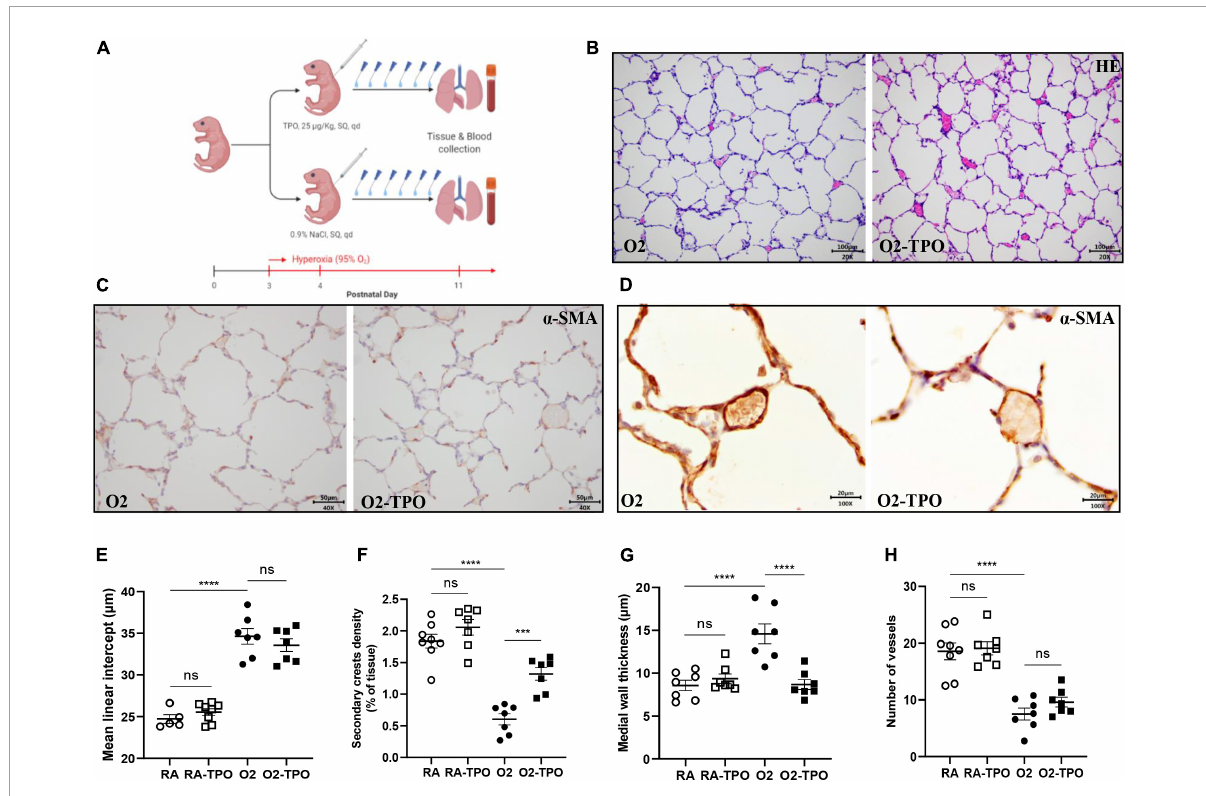
FIGURE4 TPO attenuates experimental BPD. Experimental scheme (A) of the newborn mice exposed to hyperoxia and treated with TPO or NaCl once a day from postnatal day 4 to 10. Representative images of HE (B) and α -SMA (C,D) stained lungs. Quantification of MLI determined on HE stained lung (E) , secondary crest density corrected by tissue area determined on α -SMA stained lung (F) , medial wall thickness (G) and the number of vessels (H) . Data are expressed as mean ± SEM, *** p < 0.001, **** p <